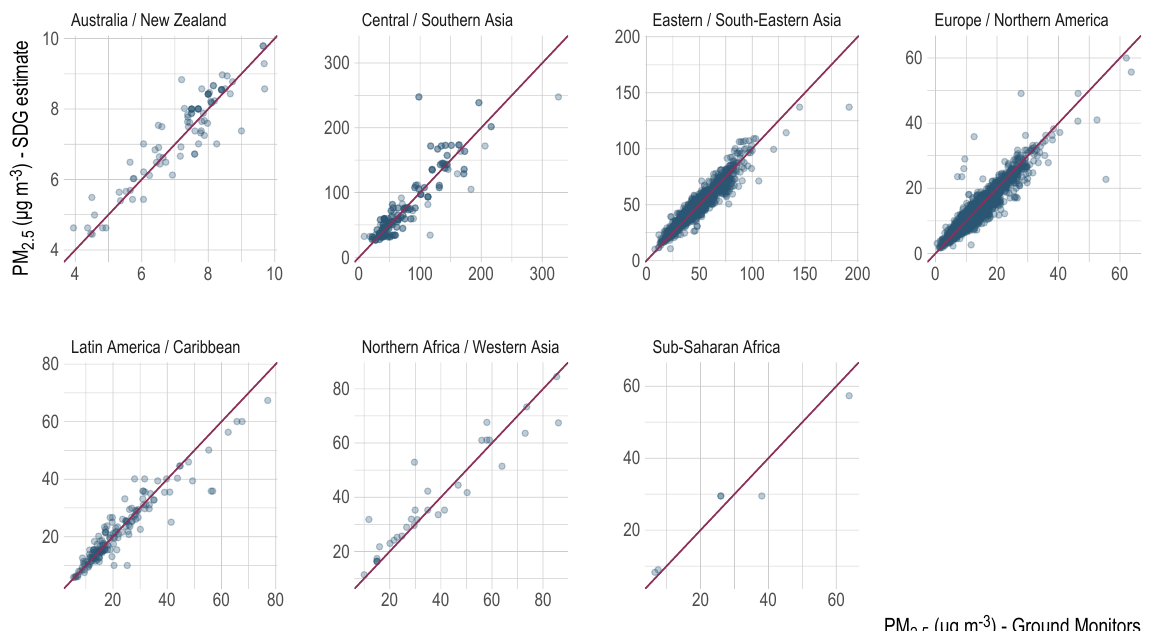
Figure 2. Comparison between the estimates of annual average of PM 2.5 from Data Integration Model for Air Quality (DIMAQ) and ground measurements, by SDG region, for 2016. Red lines indicate a one-to-one relationship.